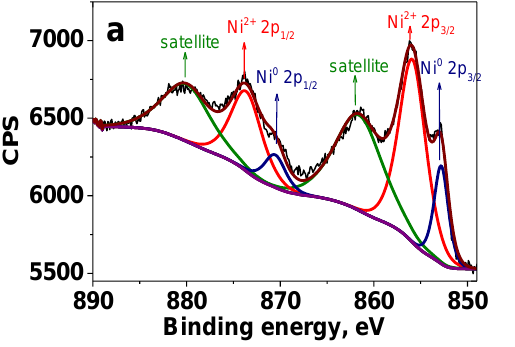
Figure 5. HR XPS of the Ni 2p region for Ni NPs@PPP prepared at 220 °C ( a ) and 280 °C ( b ) by the heat-up method. Deep blue is for Ni 0 , red is for Ni 2+ , green line represents Ni 2+ satellites, brown is for generated fit, purple is for background and black is for raw data. See Table S1 and Figure S3 for the deconvolution parameters and survey spectrum, respectively.